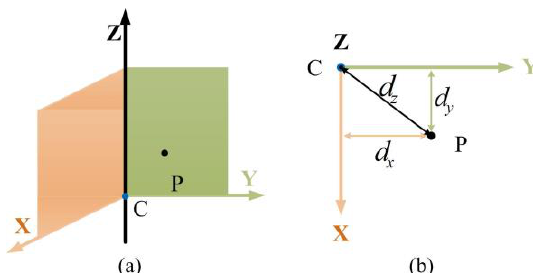
Figure 5. a) The local reference frame defined by PCA. b) The distances calculated in local reference frame.